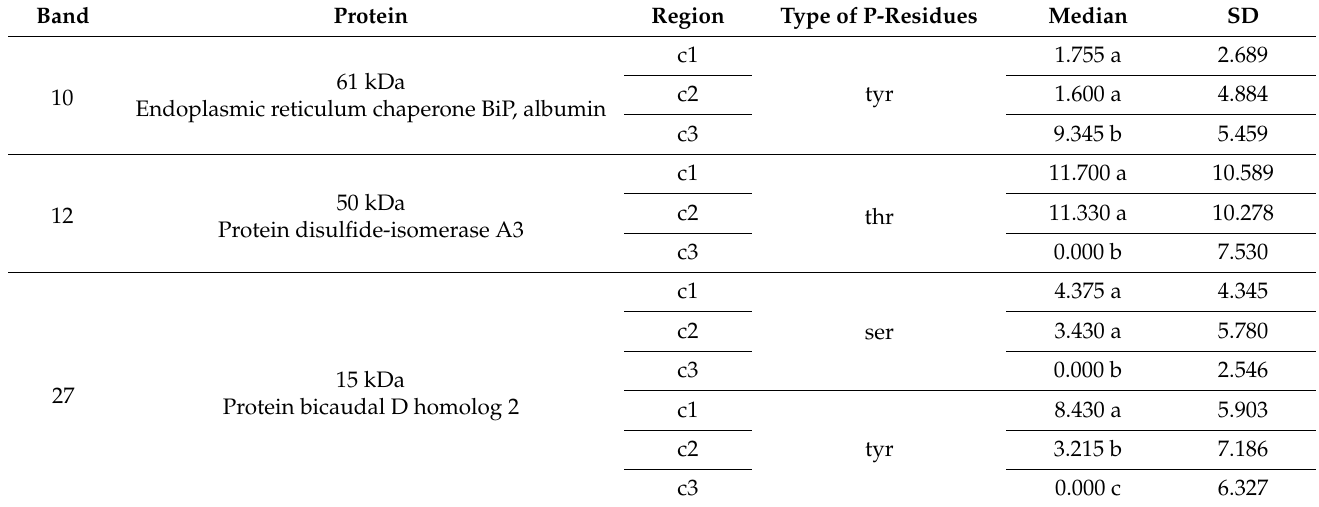
Table 3. Medians with standard deviations (SD) estimated for protein phosphorylation intensity (%) of every fraction (epididymal region × type of phosphorylated